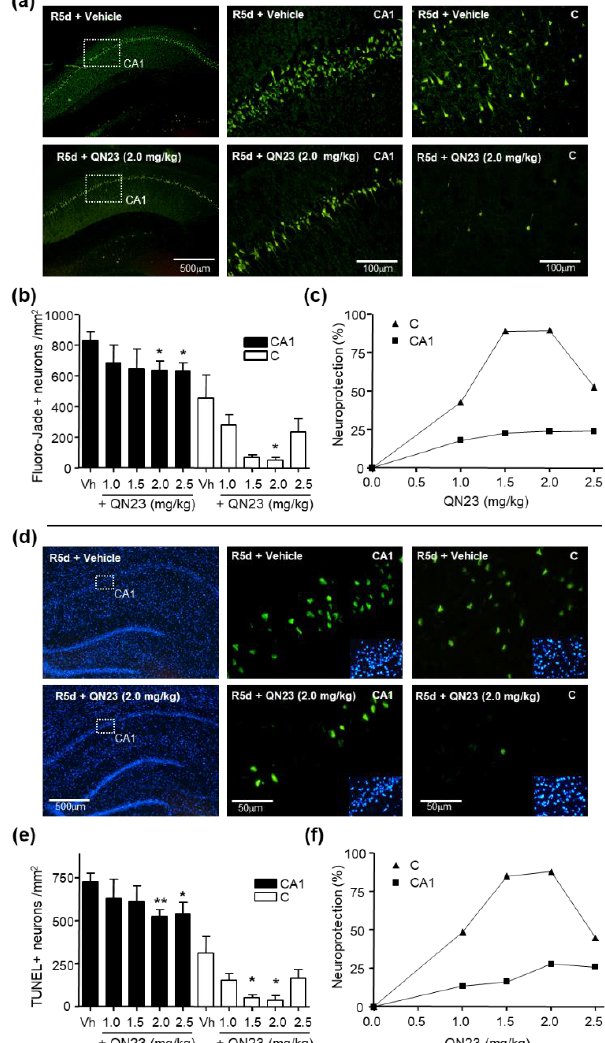
Figure 1. Dose–response curve of QN23. Ischemic animals were treated with vehicle or QN23 (1.0–2.5 mg/kg) by intravenous injection at reperfusion onset after global cerebral ischemia, and the effect of QN23 was studied by assessing neuronal death and apoptosis after 5 days of reperfusion (R5d). ( a ) Representative images of Fluoro-Jade B-stained brain sections from vehicle- or QN23-treated animals (R5d + vehicle and R5d + QN23, respectively). Fluoro-Jade B-positive dead neurons were visualized by fluorescence microscopy (in green) in the hippocampal CA1 (CA1) and cortical (C) regions, and counted as described in the Materials and Methods section. ( b ) Bar graph representation of the neuronal death quantified in brain sections stained with Fluoro-Jade B in CA1 and C regions. Data represent the mean of 9 independent animals treated with vehicle, and 6–7 independent animals per QN23 treatment group; error bars indicate the SE. * p < 0.05 and ** p < 0.01, compared with the R5d + vehicle (Vh) by Dunnett’s post -test after ANOVA. In ( c ), data from ( b ) are represented as neuroprotective activity of QN23. Neuroprotection was defined as the effect achieved relative to the neuronal death value observed in the R5d + vehicle group (Vh) (0% value) and to the absence of neuronal death (100% value). Data are represented as mean ± SE. ( d ) Brain sections as in ( a ) were used for apoptosis detection by TUNEL assay and visualized by fluorescence microscopy (in green) in CA1 and C regions. Images are representative of the TUNEL assay, with the corresponding Hoechst counterstaining. TUNEL-positive cells were counted in CA1 and C regions as described in the Materials and Methods section. ( e ) Bar graph representation of neuronal apoptosis quantification, performed as in ( b ). In ( f ), data from ( e ) are represented as in ( c ).